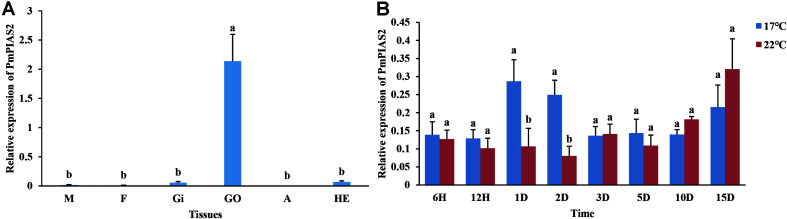
Expression pattern of PmPIAS in tissues and cold tolerance. (A) Presents the expression pattern of PmPIAS in tissues. M, mantle; F, foot; GI, gill; GO, gonad; A, abductor muscle; HE, hepatopancreas. (B) Shows the expression pattern of PmPIAS under cold tolerance stress (17°C). Columns with different letters are significantly different (P < 0.05).